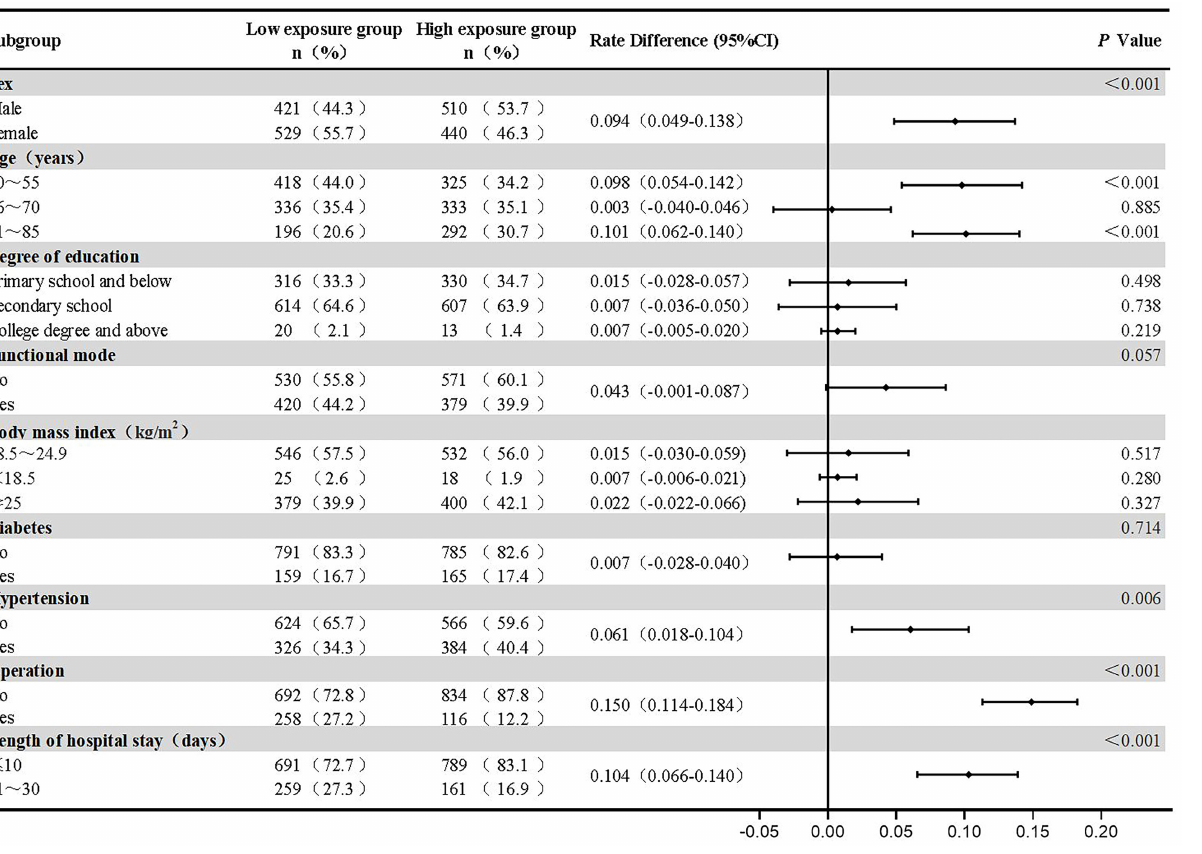
FIGURE 2 | Subjects’ baseline demographic and clinical characteristics stratified by mean daily duration of intravenous infusion.